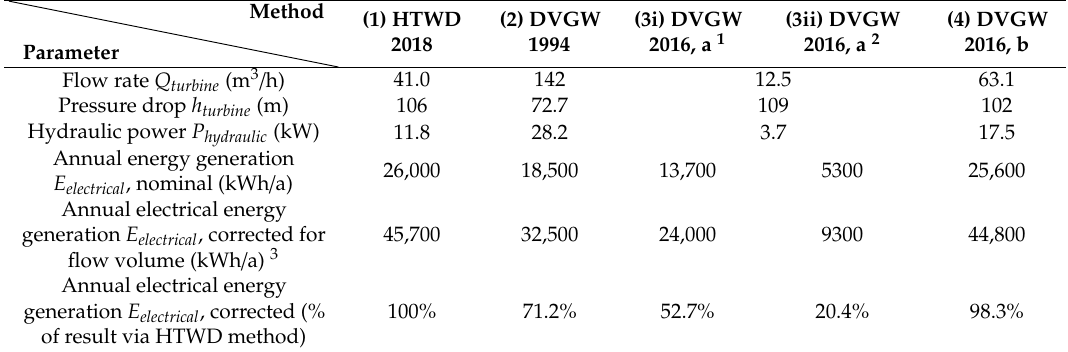
Table 4. Summary of the results for BPT Rützengrün using all four methods described in this article.